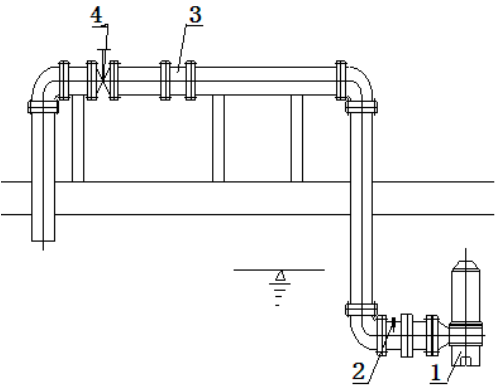
Figure 9. A schematic diagram of the test device. (1) Test pump, (2) Pressure measuring tube, (3) Flowmeter, (4) Valve.